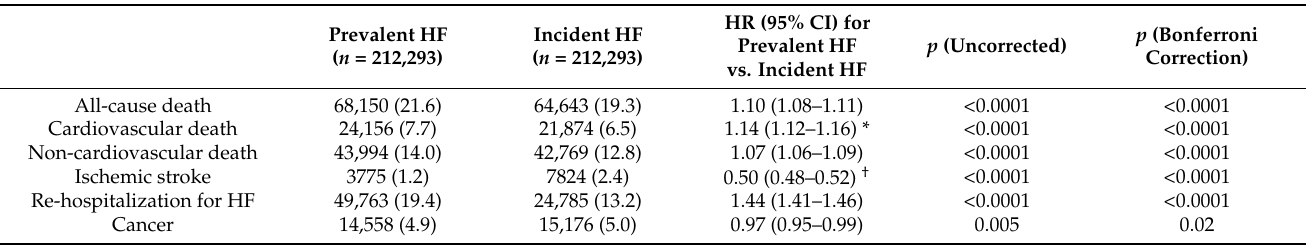
Table 5. Clinical outcomes during the whole follow-up in the matched cohort of patients with AF and prevalent or incident HF with follow-up starting at the time of last event between AF or HF.